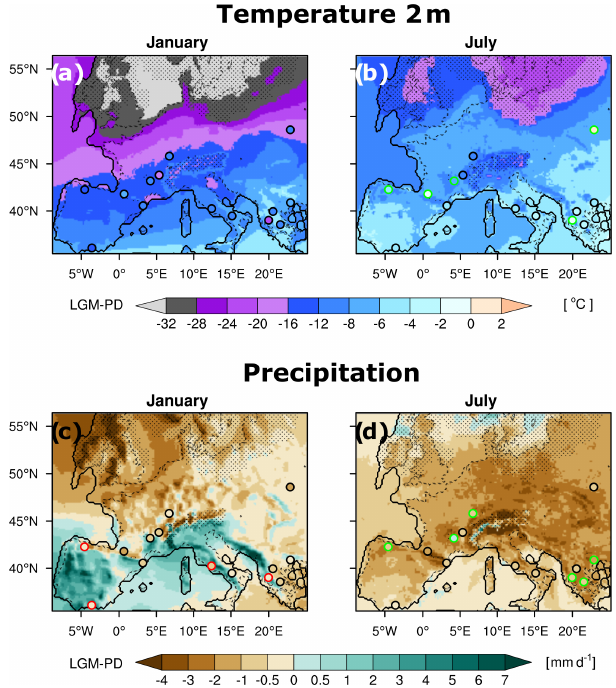
Figure 5. Changes in temperature and precipitation patterns. Panel (a) represents the differences in 30-year mean temperature between LGM and PD (LGM LGM – PD PD ) for January. Panel (b) is the same as (a) but for July. Panels (c) and (d) are the same as (a) and (b) but for precipitation differences. Circles represent proxy evidence: a red (green) border indicates that the simulated value is significantly above (below) the proxy value at the closest grid cell of the model (outside the 90% confidence interval, Wu et al., 2007). The solid line represents the LGM coastline, the dashed line the PD coastline, and dots the area covered by